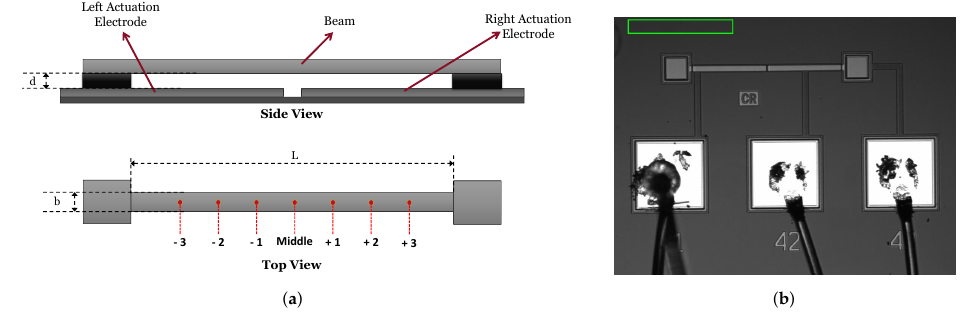
Figure 2. MEMS device under test: ( a ) side and top views showing the locations of the measurement points along the beam span, ( b ) a microscopic